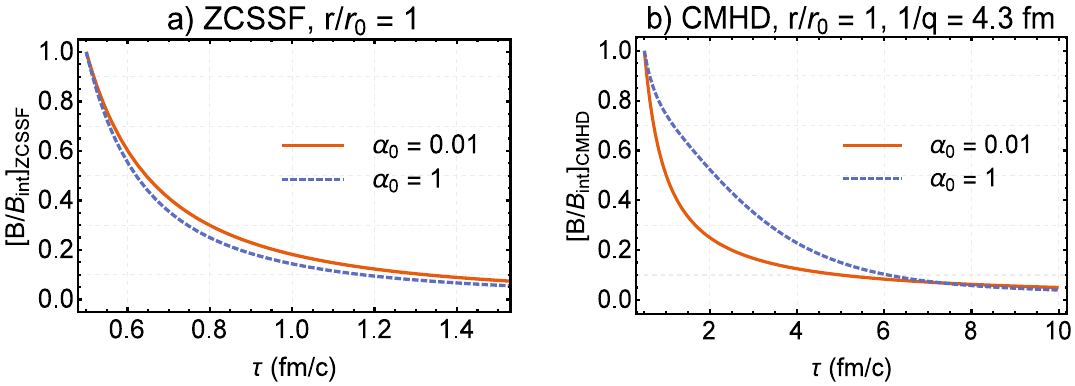
Figure 3 . (color online). The τ dependence of B/B init. for the ZCSSF solution (panel a) and CMHD solution (panel b) is plotted at r = r 0 and for α 0 = 0 . 01 (solid orange curve) and α 0 = 1 (dashed blue curve). For the CMHD solution q is chosen to be q = 1 / 4 . 3 fm − 1 . Whereas B/B init. for the ZCSSF solution drops below 0 . 1 around τ 1 fm / c, B for the CMHD solution becomes 0 . 1 B init. ∼ at τ 6 fm / c. In contrast to B CMHD , the decay of the ZCSSF field turns out to become faster, ∼ if the initial magnetic field has a large component along the beamline. The latter is characterized with larger α 0